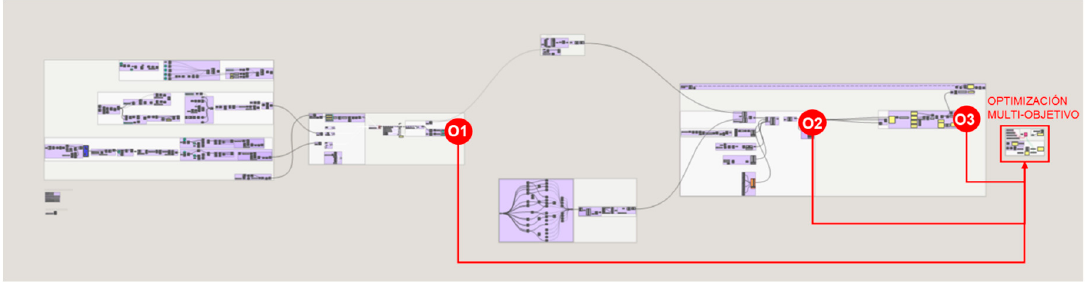
Figure 37. Location of the objectives of the multi-objective optimization problem within the programming structure definition of the methodology for the case study.